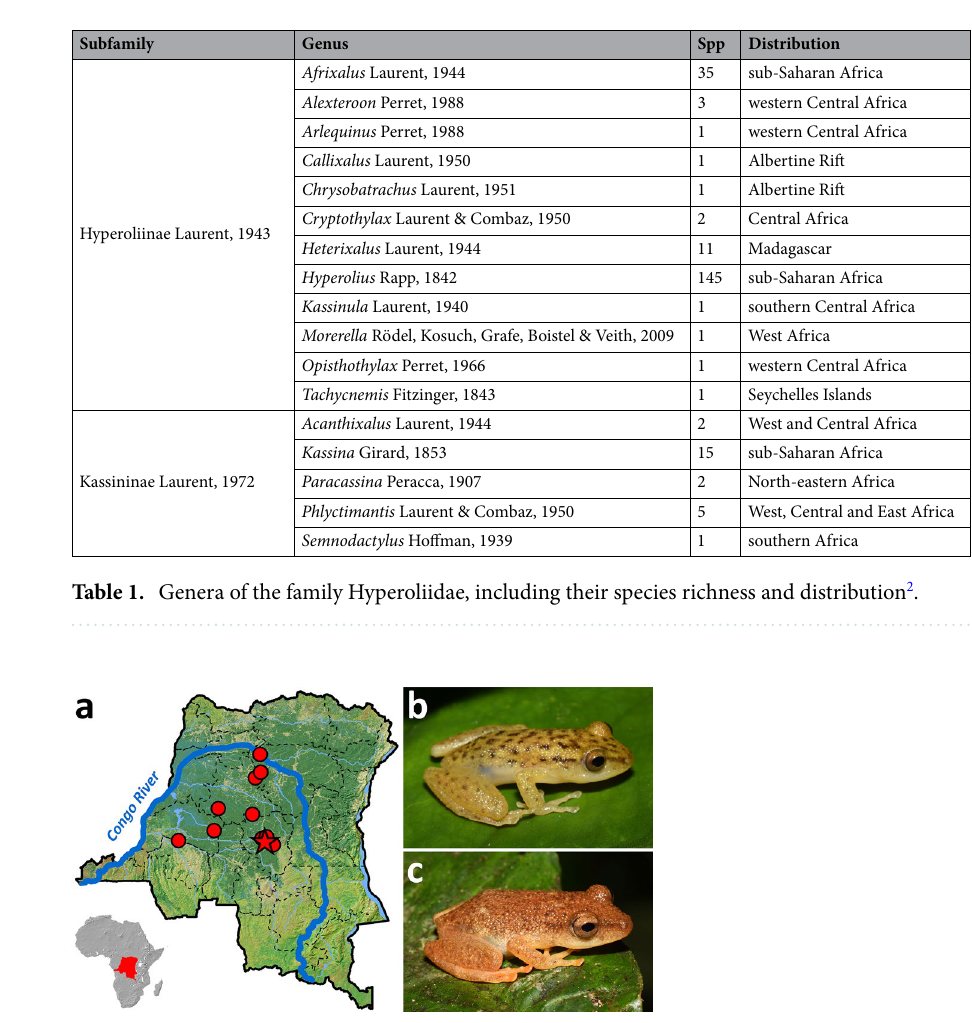
Figure 1. Hyperolius robustus —now in the new genus Congolius —and its distribution. ( a ) All known localities lie to the south of the wide arc of the Congo River (left bank), within the Democratic Republic of the Congo; star denotes type locality. Photographs of ( b ) adult male (IVB-H-CD18-143) and ( c ) adult female (NMP-P6V 76087/2) from the Kokolopori Bonobo Nature Reserve. Photos by